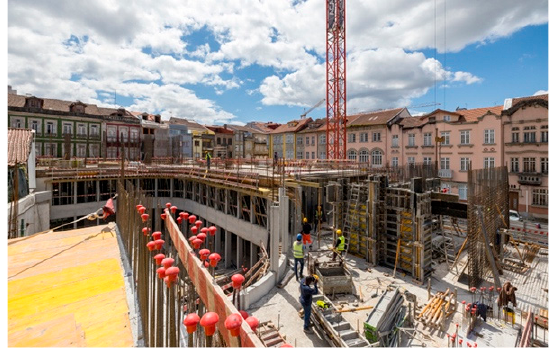
Figure 15. Building at Braga. ©João Ferrand.